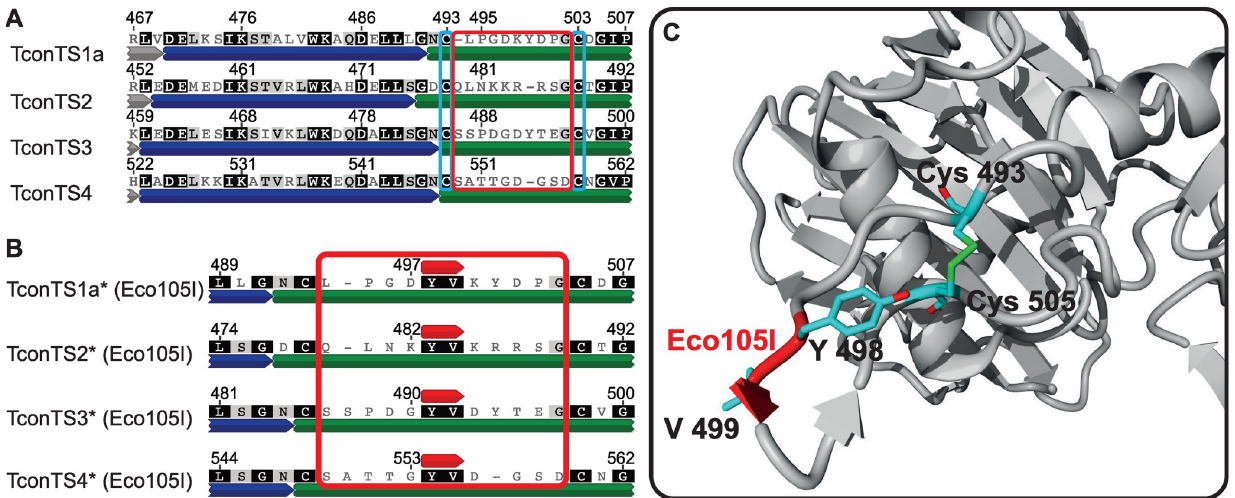
Fig 3. Insertion of Eco105I endonuclease restriction site into TconTS. A: A section of the complete amino acid sequence alignment of TconTS1a through TconTS4 with assigned structural elements (Grey, blue and green for CD, α -helix and LD, respectively). Cysteine residues Cys493 and Cys503 in TconTS1a forming a well conserved disulphide bridge in TS are marked with light blue frames, whereas the resulting hairpin loop flanked by these cysteine residues is marked with a red frame. B: Amino acid sequence alignment of the hairpin loop region with the Eco105I restriction site inserted (red annotation above each TconTS sequence, resulting in Tyr-Val insertion). Alignments were calculated as described under Methods. Numbers on top of each sequence indicate the corresponding residue numbers in the individual TconTS before the insertion. TconTS comprising the inserted Eco105I restriction site are labelled ( � ). Increasing darkness of background for each residue indicates increasing number of identical amino acid residues at the corresponding position. C: Homology model of TconTS1a � showing a region of the lectin domain (grey), including the well conserved disulphide bridge Cys493-Cys505 and the hairpin loop with the Eco105I insertion (red label). TconTS1a � homology model was calculated as described under Methods.